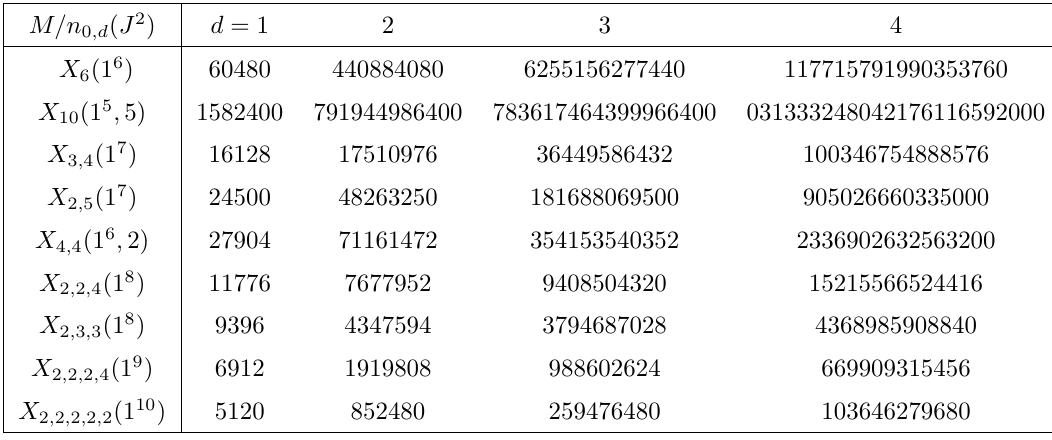
Table 1 . Genus 0 invariants in F (0) for nine hypergeometric one parameter CY fourfold J 2